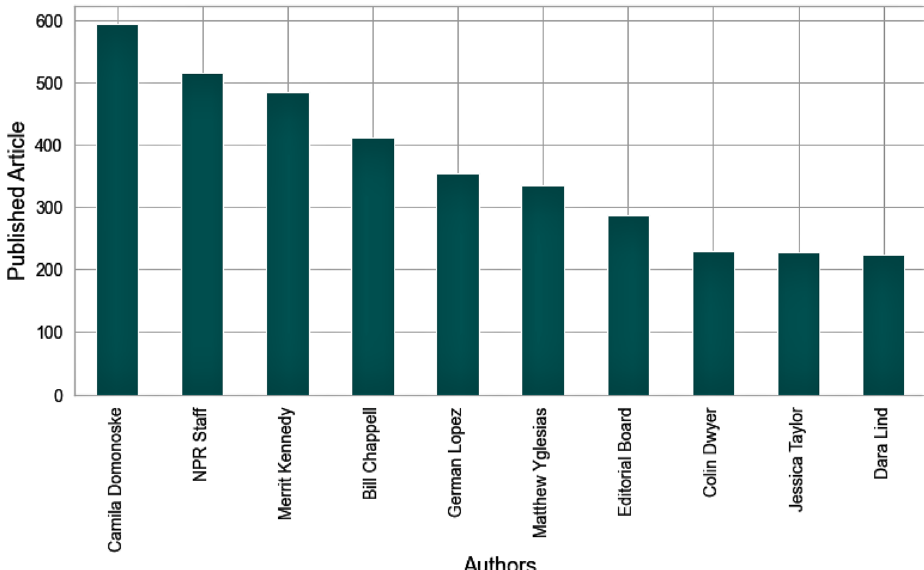
Figure 5. Top 10 authors in article3 dataset.